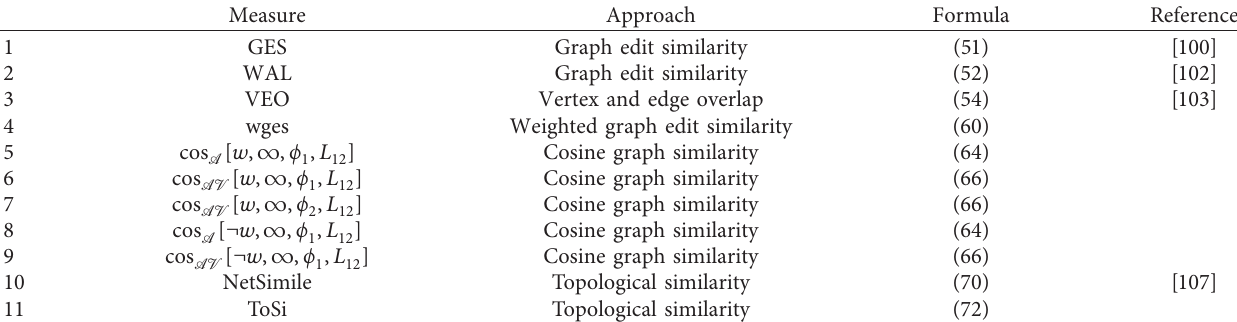
Table 5: The list of measures of graph similarity used for computing the similarities of topic networks.